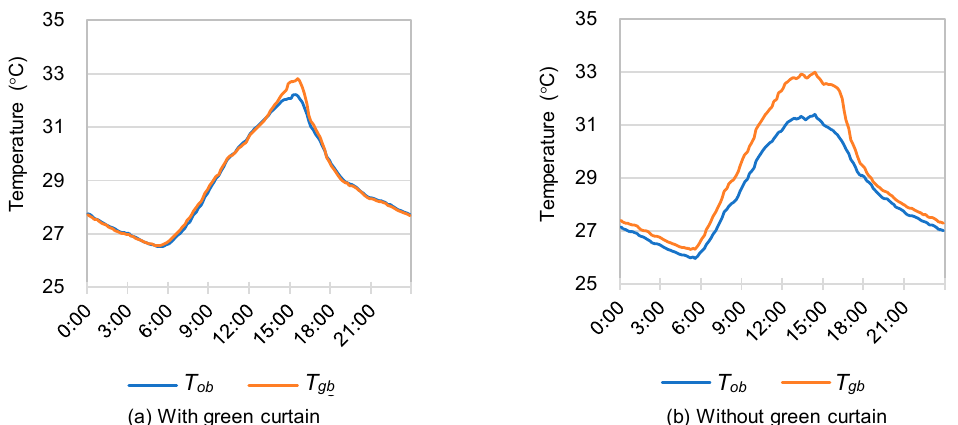
Figure 12. Variation in the balcony of air temperature ( T ob ) and globe temperature ( T gb ).